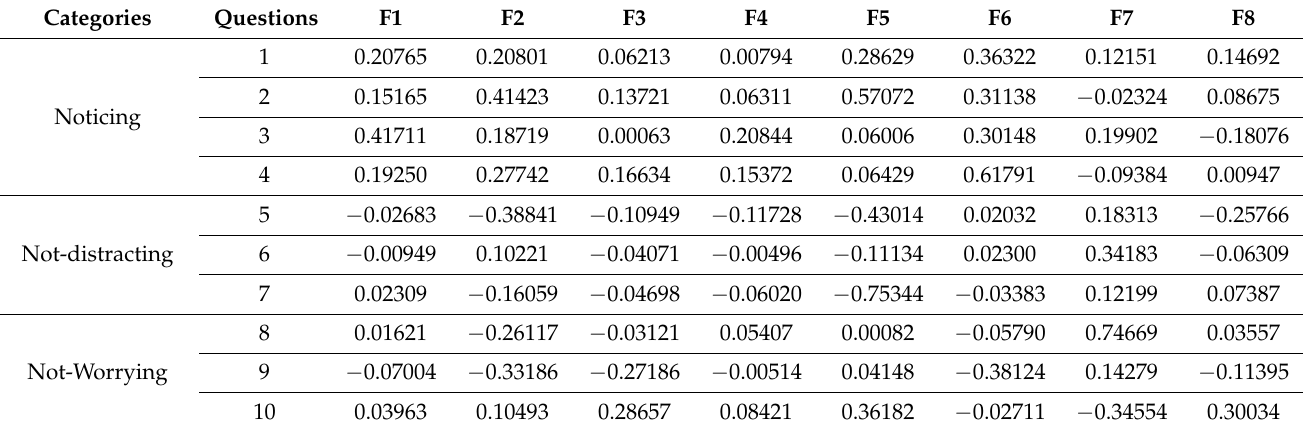
Table 5. Factorial load by questions according to MAIA